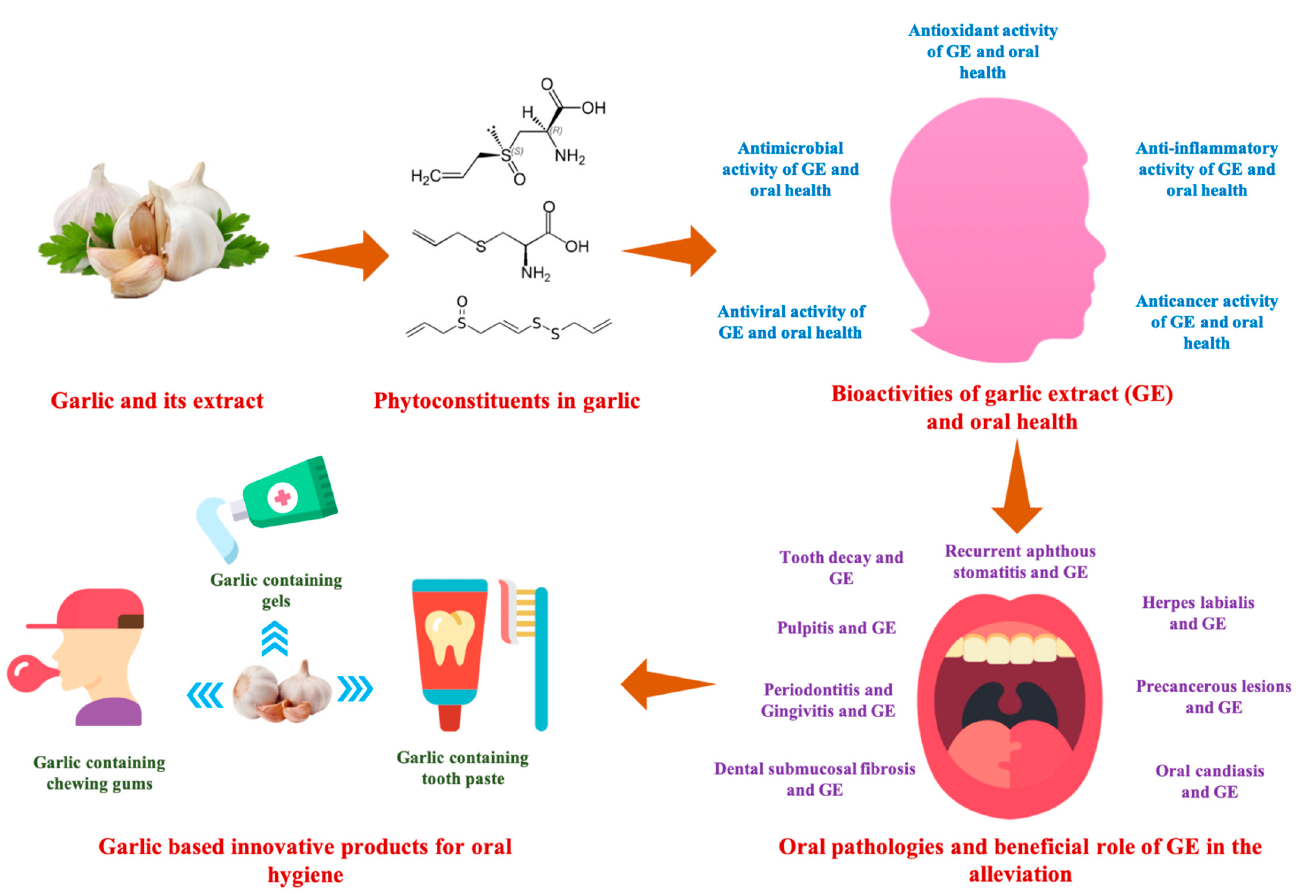
Figure 1. Various components discussed in the current review.